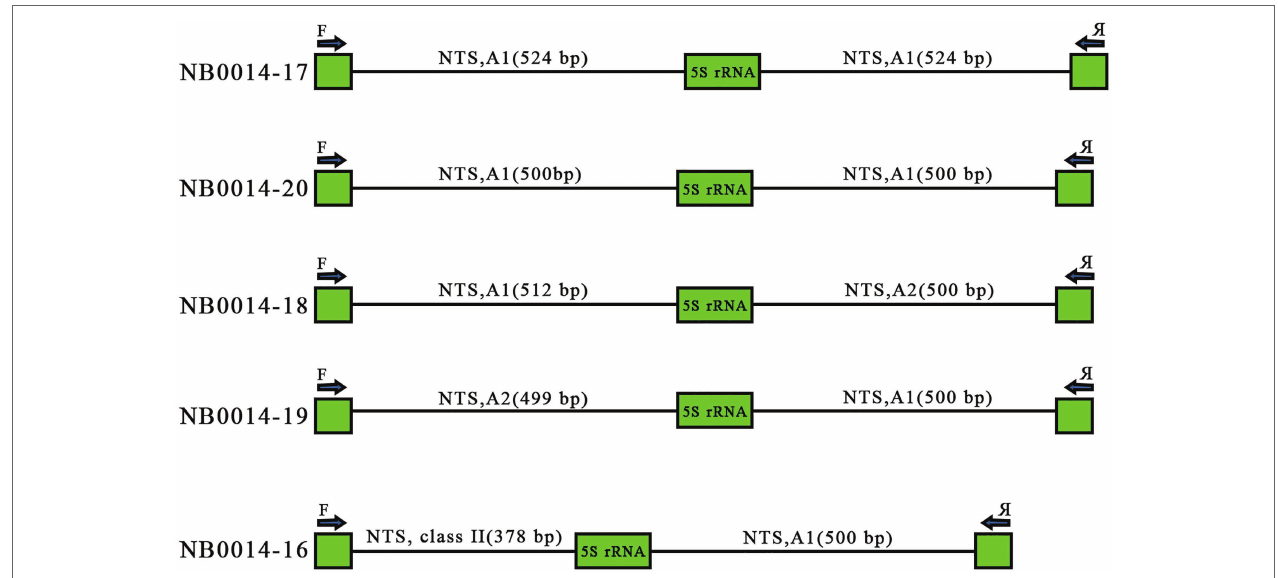
FIGURE 5 | Various modes of 5S rDNA unit arrangement in clones containing pairs of consecutive repeated units. Clones NB0014-17 and NB0014-20 each contain identical A1 type NTS sequences of 524 bp and 500 bp, respectively. Clones NB0014-18 and NB0014-19 have interspersed type A1 and A2 units, whereas the clone NB0014-16 has interspersed class II and class I, type A1 units. NTS, nontranscribed